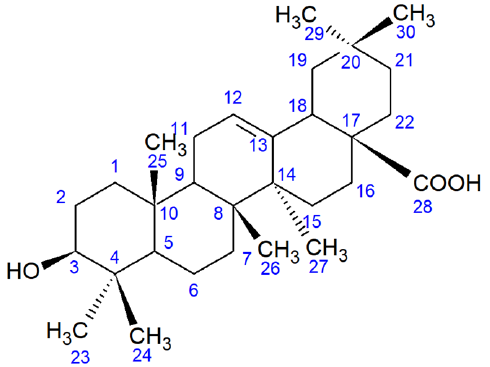
Figure 1. Structural formula of OA.